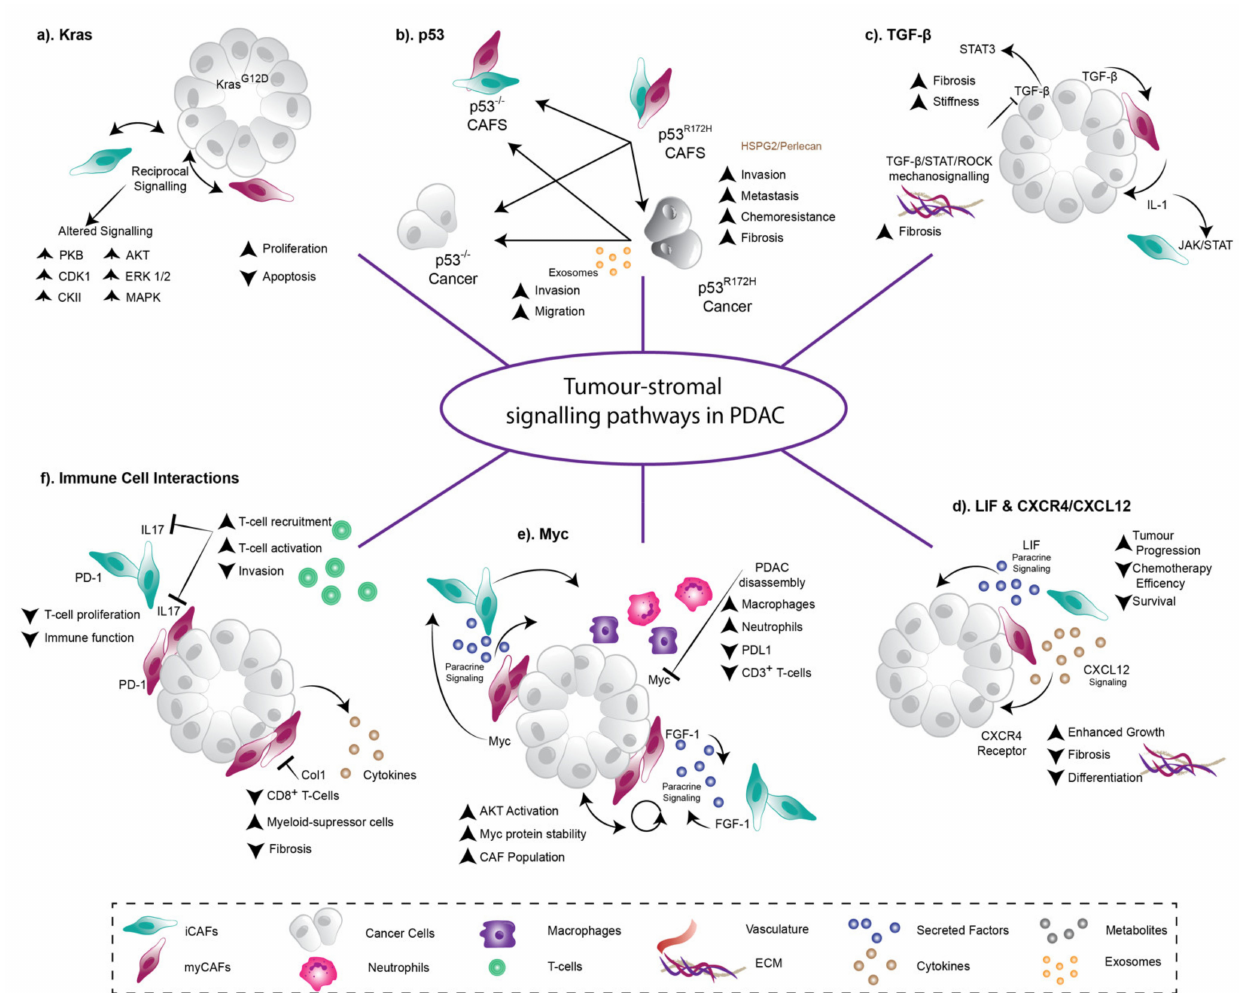
Figure 2. Heterotypic tumor-stroma signalling drives pancreatic cancer development, progression, invasion, and metastasis. ( a ) Reciprocal Kras G12D signalling between tumor and stromal cells regulates signalling axes, which influence cancer cell proliferation and apoptosis [74]. ( b ) Cancer cells with distinct p53 mutations can modulate neighbouring and distant fibroblasts to establish a fibrotic, pro-invasive and pro-metastatic environment [29,75]. ( c ) TGF- β signalling via STAT3 increases desmoplasia and stiffening of the tumor ECM and is fundamental in the distinct formation of myCAFs and iCAFs. Additionally, tumor secreted TGF- β acts on adjacent myCAFs and antagonises IL-1 secretion to further activate JAK/STAT signalling [76]. ( d ) Chemokine receptors CXCR4 play a crucial role in stromal desmoplasia. Here, signalling enhances tumor growth whilst also decreasing fibrosis and cell differentiation [77]. Similarly, LIF paracrine signalling promotes tumor progression whilst also decreasing chemotherapeutic efficiency [78]. ( e ) The transcription factor, Myc mediates the expression of multiple genes to coordinate cell proliferation. In the stromal compartment, early PanIN activation triggers paracrine signalling, which then induces stromal and immunological changes, driving disease progression [79]. ( f ) Within the pancreatic tumor microenvironment, innate and adaptive immune cells affect disease progression. Knockdown of Interleukin-17 in fibroblasts leads to an anti-tumor immune microenvironment, including increased cytotoxic T-cell recruitment [80]. Conversely, high PD-1 expressing fibroblasts contributed to a diminished immune function and T-cell proliferation